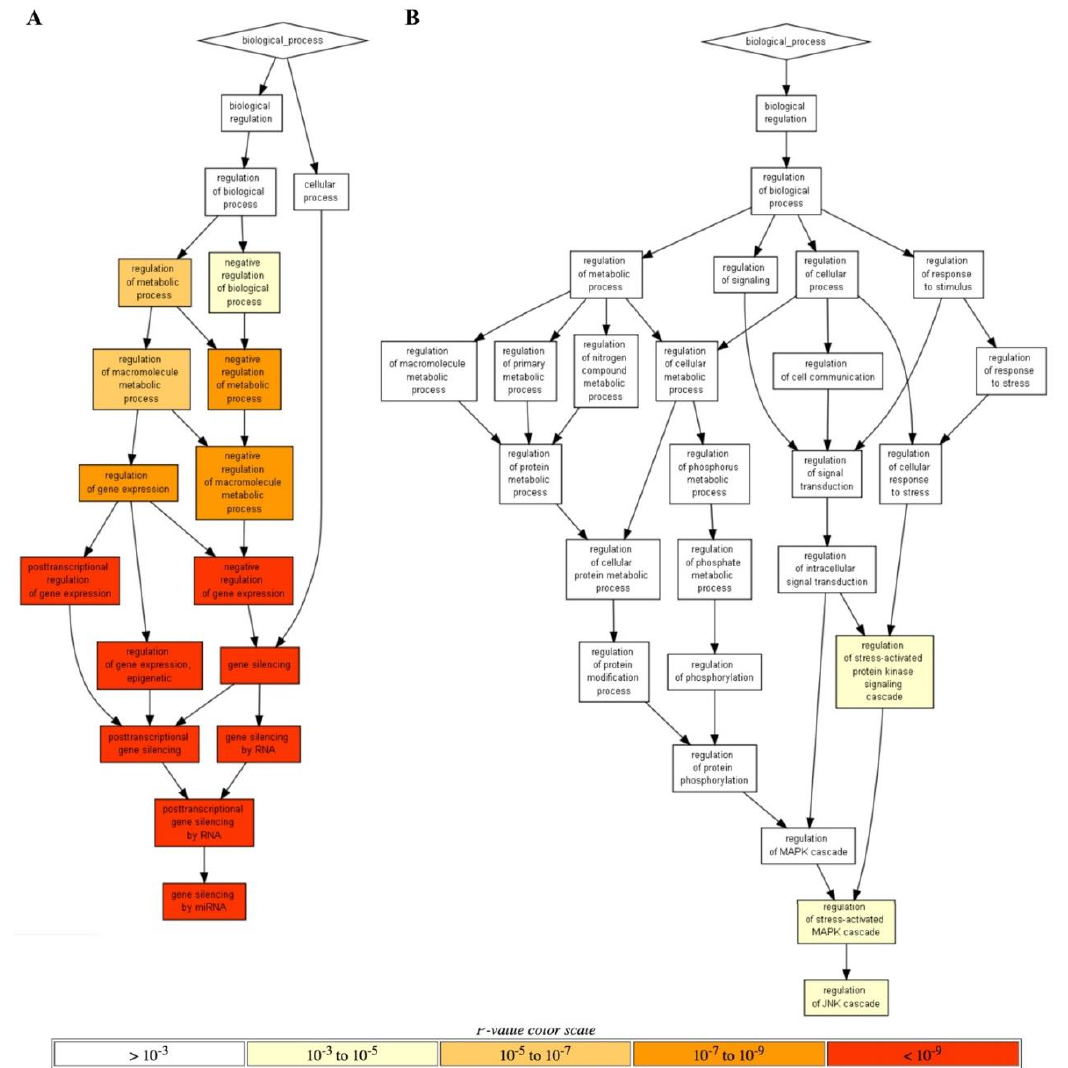
Figure 5. Hierarchically ordered GO annotated terms detected by Gorilla software for RRE-enriched ( A ) and RRE-deficient ( B ) genes for all REs.